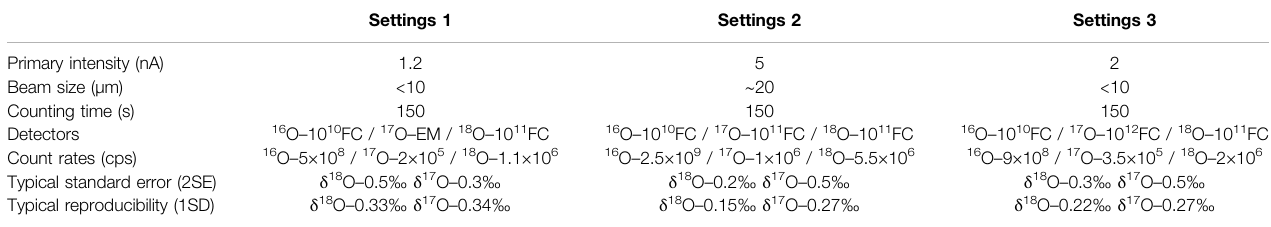
TABLE 1 | Primary beam parameters, counting times, multicollection con fi gurations, typical counts rates and uncertainties observed for the three different MC-SIMS settings. Settings